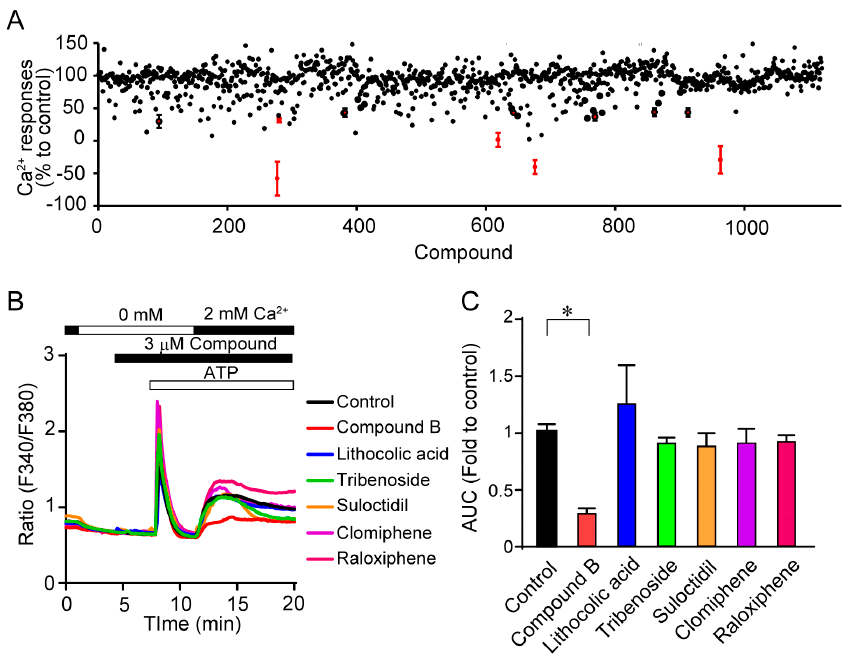
Figure 2. Effects of validated compounds on TRPC3-dependent increases in intracellular Ca 2+ concentrations. ( A ) Summary of inhibitory effects of all compounds except TRPC3/6 inhibitors. The percentage of Ca 2+ responses to control was presented. Red points with error bars were selected as